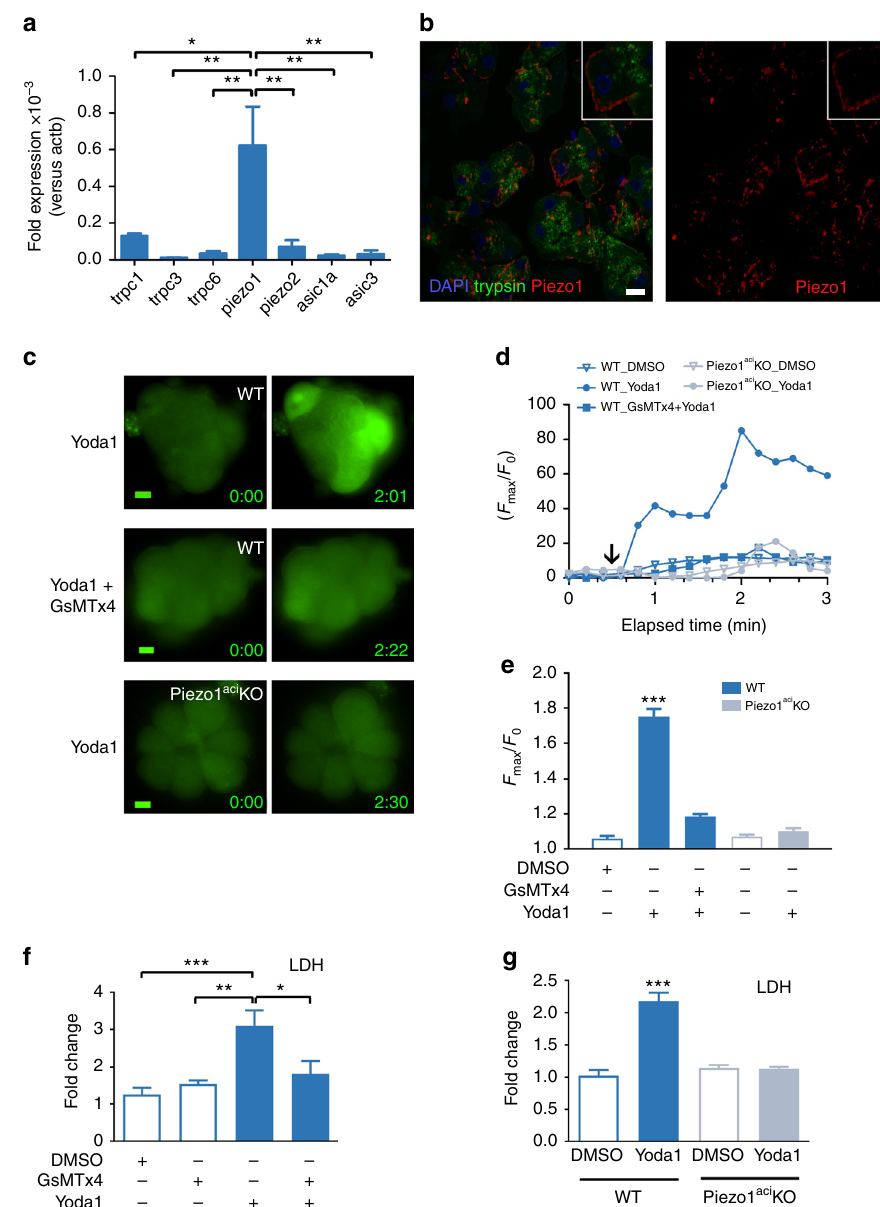
Fig. 2 Piezo1 is expressed in pancreatic acinar cells. a The relative expression of mechanically activated ion channel messenger RNAs from C57BL/6J pancreatic acinar cells was analyzed by real-time RT-PCR using the ΔΔ C T method (biological n = 3). b Frozen sections (left panel) from mouse pancreatic tissue (C57BL/6J) were immunostained with antibodies against trypsin 3 (green) or Piezo1 (red). DAPI-stained nuclei are shown in blue. Inset shows a higher magni fi cation of an acinar cell. Images were taken with a ×63 objective. Bar = 10 µ m. c Representative live-cell imaging of pancreatic acini loaded with Calcium 6-QF at time 0 (left panel) and at the time of maximum fl uorescence (right panel). Images obtained with a ×20 objective. Bar = 10 µ m. d A representative time course of calcium fl uorescence in acinar cells from littermate wild-type or Piezo1 aci KO mice. Black arrow indicates when Yoda1 (25 aci KO mice. GsMTx4 was added 2 min prior to µ M) was added to the cells. e Statistical analysis of F F max / 0 in acinar cells from littermate wild-type or Piezo1 Yoda1 ( n = 3 – 5 experiments; 30 – 40 cells were analyzed for each experiment). LDH released from acini treated with Yoda1 (100 μ M) from f C57BL/6J mice or g Piezo1 aci KO and littermate (WT) mice ( n = 4 – 5). Results are expressed as fold changes compared to the control condition (absence of test agents). DMSO was the vehicle for Yoda1; fold changes were determined vs. LDH release from cells that were incubated in absence of vehicle or compound. Statistical analysis was performed using ANOVA test with Tukey ’ s post-test. * P ≤ 0.05; ** P ≤ 0.01; *** P ≤ littermates lacking the Cre gene (WT), pancreatic acinar cells from Piezo1 aci KO mice were insensitive to Yoda1 stimulation consistent with deletion of Piezo1 in these cells (Fig. 2d, e and Supplementary Movie 3). However, acinar cells of Piezo1 aci KO + mice exhibited a normal [Ca 2 ] i response to cholecystokinin (CCK) stimulation (Supplementary Fig. 3) as has been previously observed in acini from WT animals 30 .